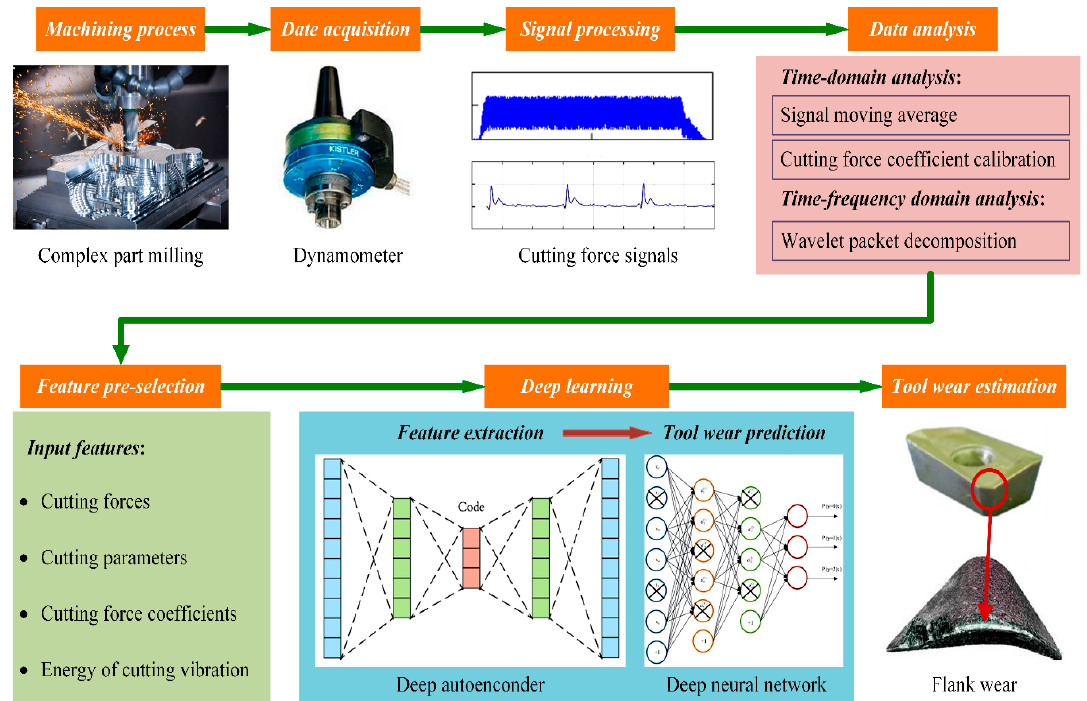
Figure 1. Framework of tool wear monitoring method for complex part milling based on deep learning.